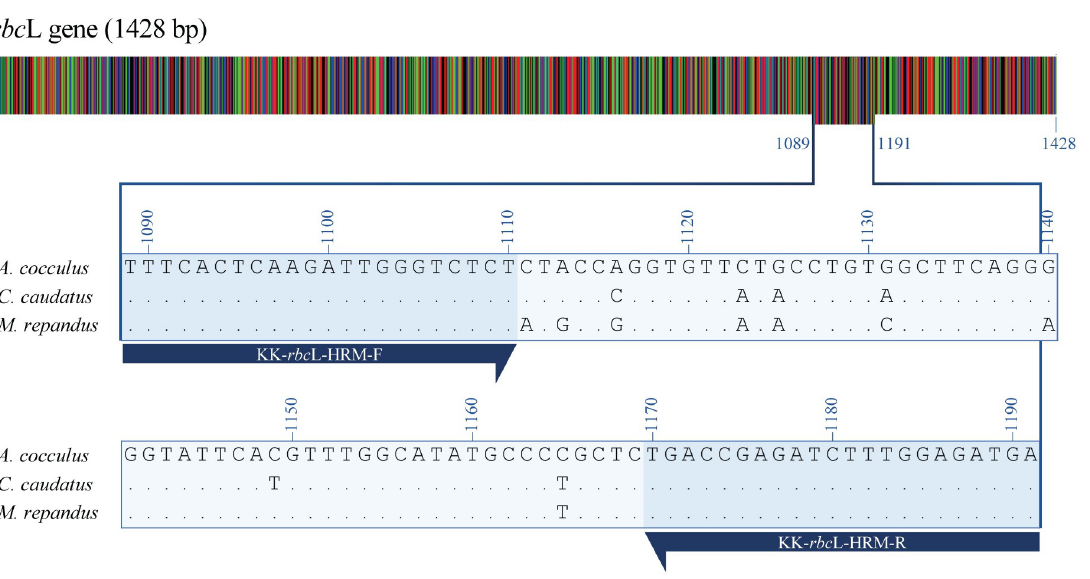
(Table 4). Gold-standard Sanger sequencing of PCR amplicons and blast analysis confirmed the original species of each amplicon. Similar melting profiles among different DNA concentrations (10 × 10 − 9 , 1 × 10 − 9 , 0.1 × 10 − 9 and 0.01 × 10 − 9 g) were revealed for M . repandus . The melting curves displayed small changes and isolated clusters at concentrations of 0.001 × 10 − 9 and 0.0001 × 10 − 9 g when analyzed using Precision Melt Analysis software (S3 Appendix).